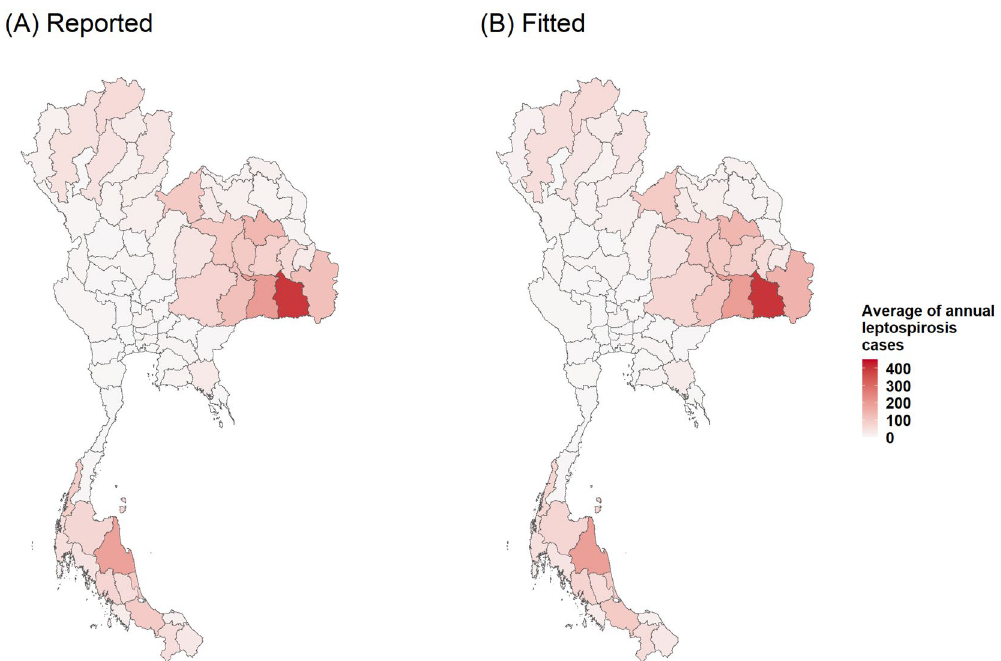
Figure 5. Plots of comparison between average annual reported leptospirosis cases ( A ) and average annual fitted leptospirosis cases estimated by the final GLMM ( B ). Maps created using R Program version 4.0.3 (https:// www.r- proje ct. org/).